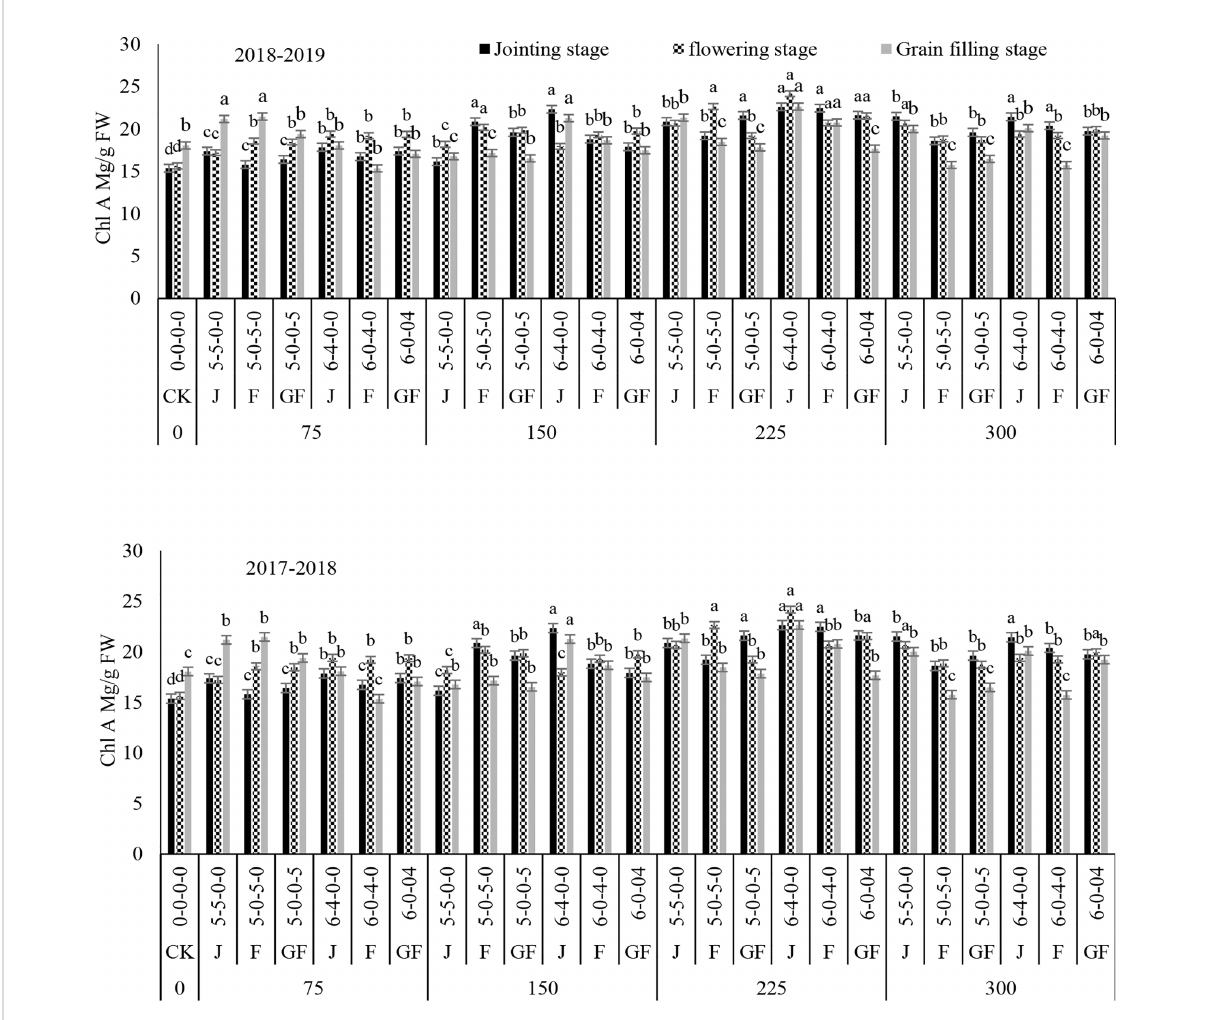
FIGURE 7 Effect of nitrogen fertilizer management on the Chl A content of winter wheat. FW , fresh weight; JS , jointing stage; FS , fl owering stage; GF , grain fi lling stage. Different letters in above bars indicate a signi fi cant difference